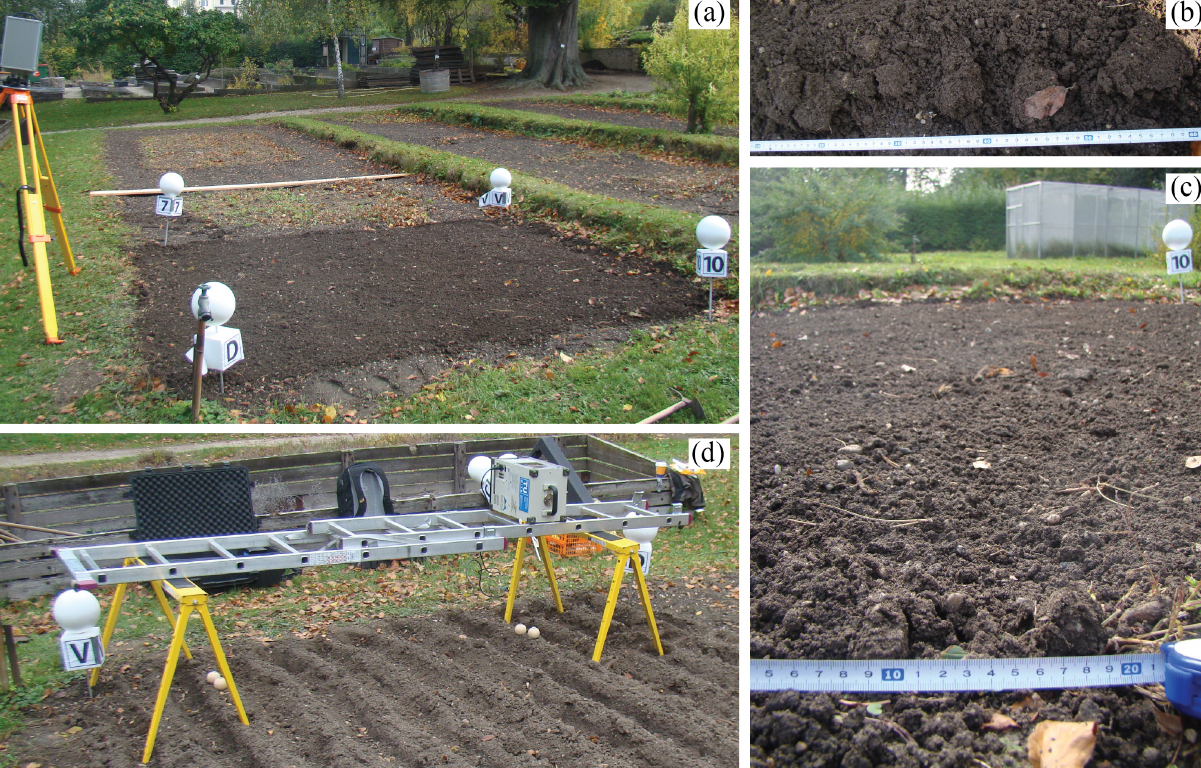
Figure 1. ( a ) Measurement setting of the TLS instrument over the analyzed plot; ( b , c ) soil aggregates and other roughness elements present within the plot; ( d ) measurement setting of the optical triangulating scanner (OTS) instrument (since a photo of the OTS setting over the on another roughness plot, which is not considered in this